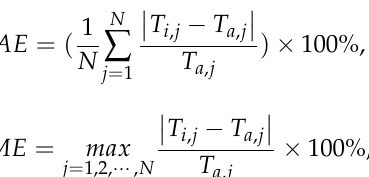
Figure 9. Identified tension compared with actual tension. ( a ) Identified tension using Sensor 1 with different frequencies and ( b ) identified tension using 8th order frequency with different sensors.